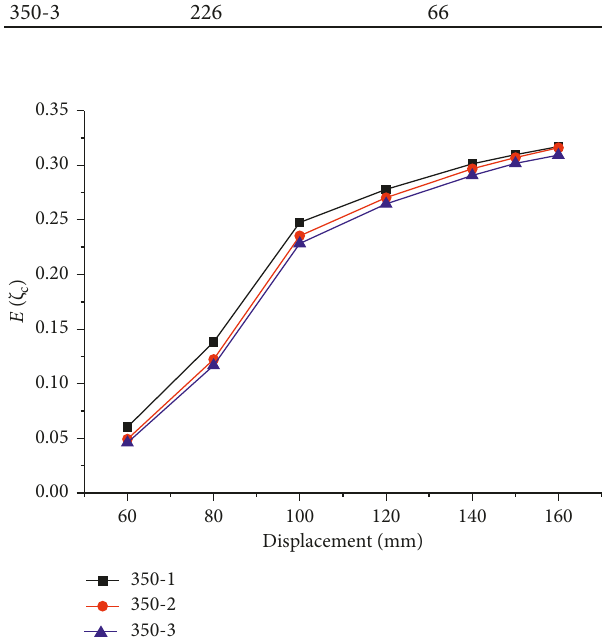
Figure 13: Equivalent viscous damping ratio ξ absorbing